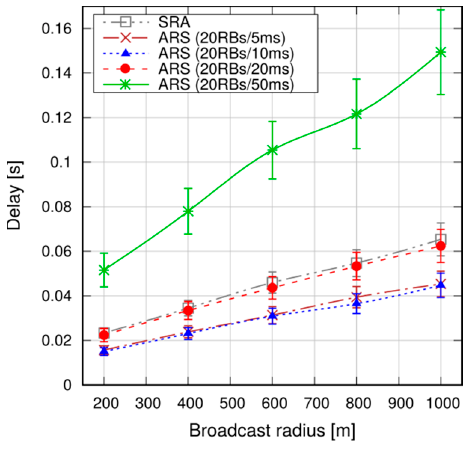
Figure 16. SRA vs. ARS, average delay.